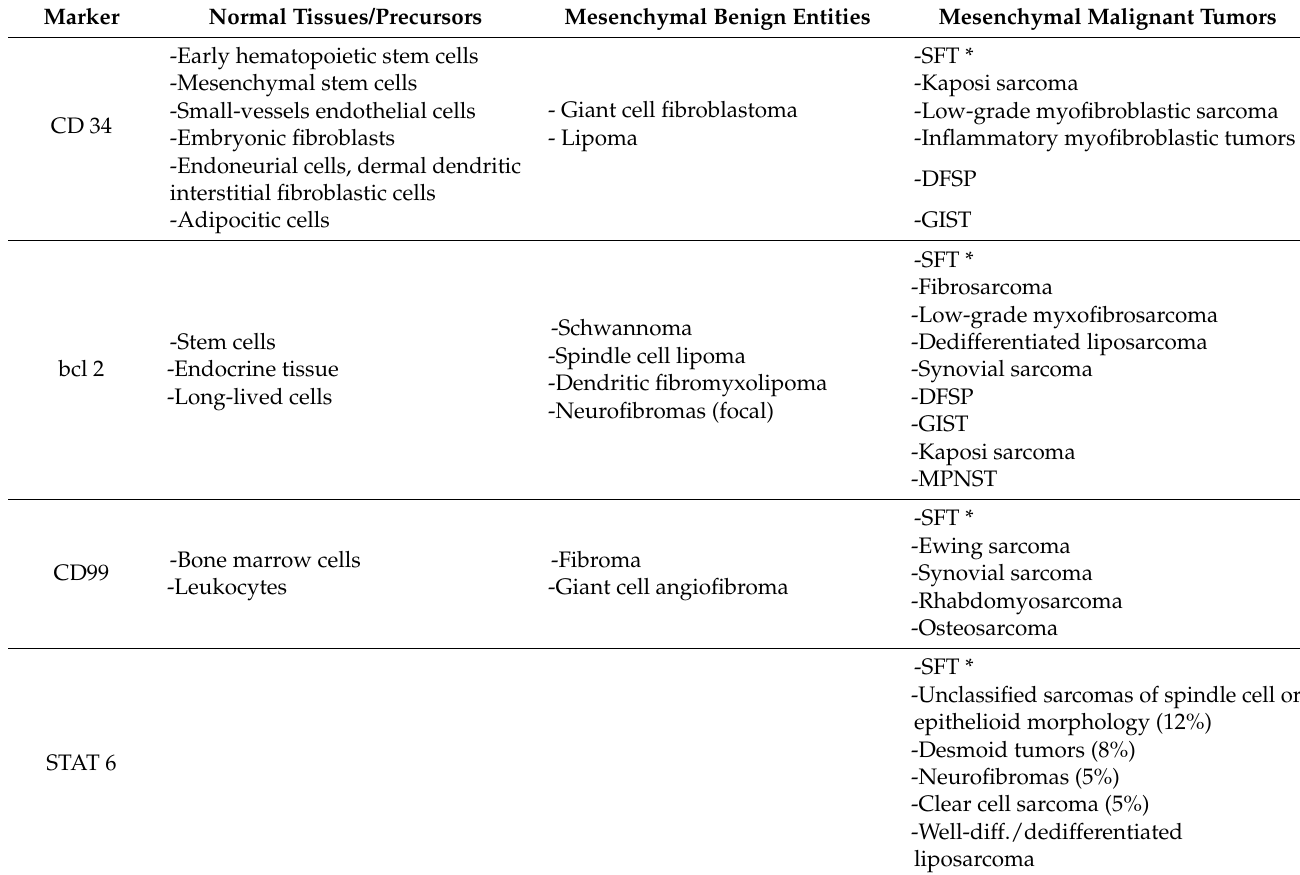
Table 2. Immunohistochemical markers commonly expressed in solitary fibrous